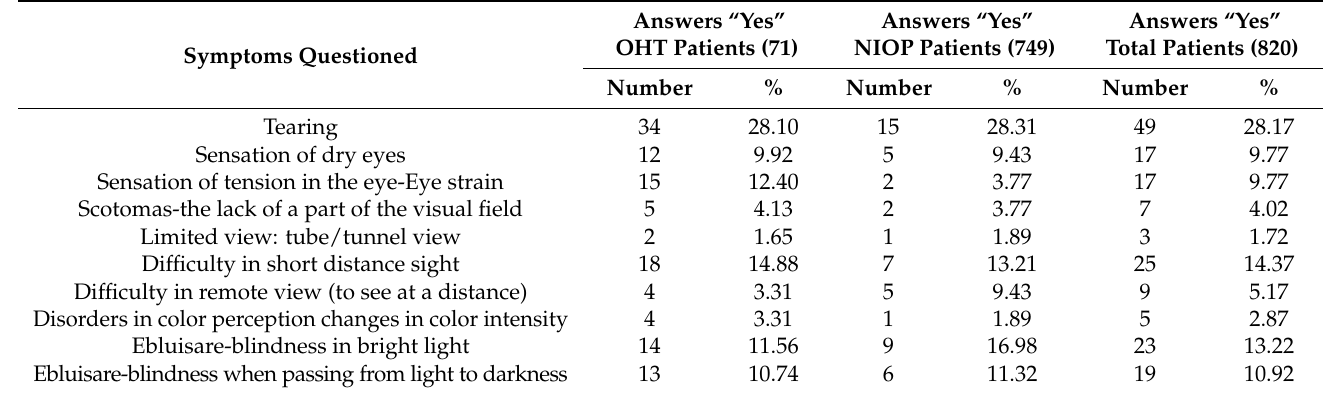
Table 9. Comparative distribution of affirmative responses to the questionnaire, “Symptom inven- tory”, in the suspected OHT and NIOP